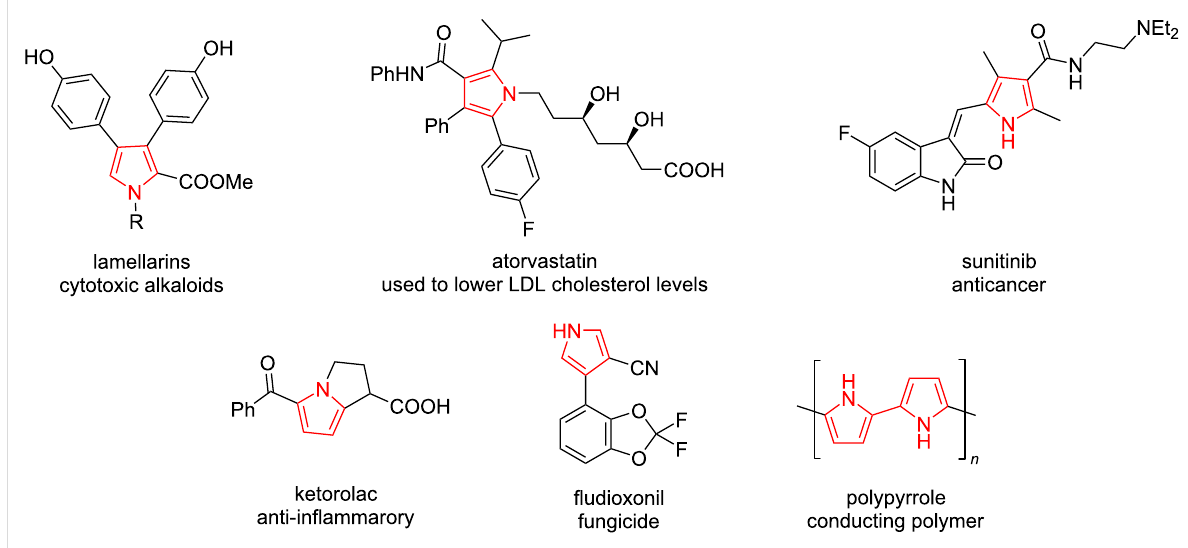
Figure 1: Selected pyrrole-containing natural products, drugs, agrochemicals, and functional materials.